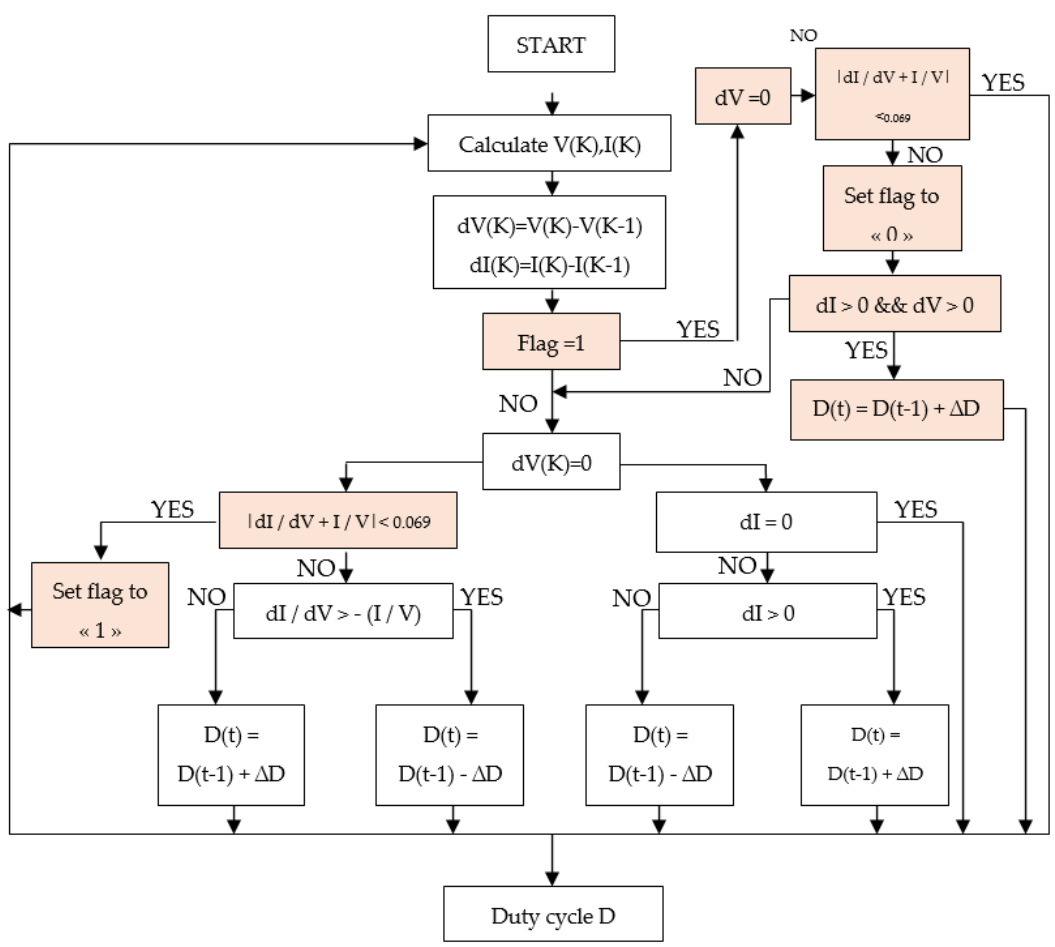
Figure 6. Flowchart of modified INC algorithm.